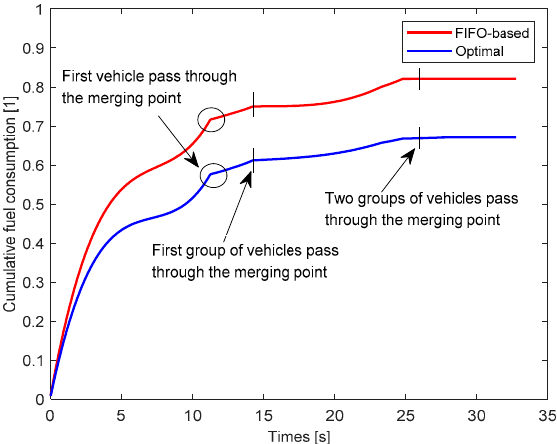
Figure 10. Cumulative fuel consumption of vehicles for case study 2.